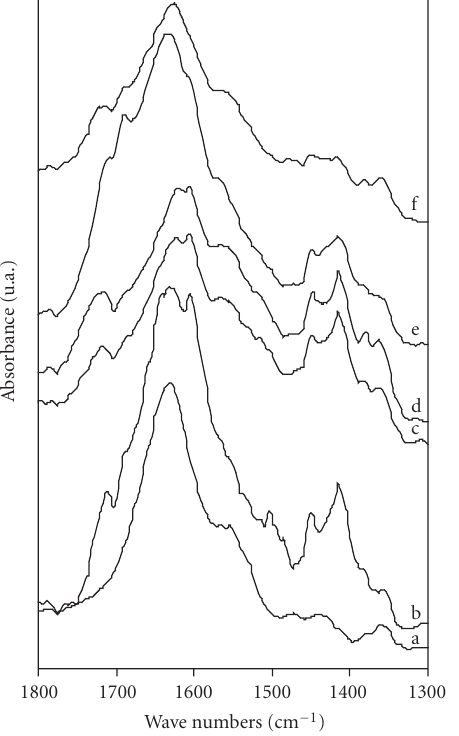
Figure 8: FT-IR spectra of fresh aggregates of TiO 2 particles (a), deactivated aggregates of TiO 2 particles (b), TiO 2 particles regener- ated in air flow under UV irradiation for 1 hour (c), 2 hours (d), 4 hours (e), and 6 hours (f) in the region between 1800–1300 cm − 1 . The spectra have been displaced vertically for clarity.